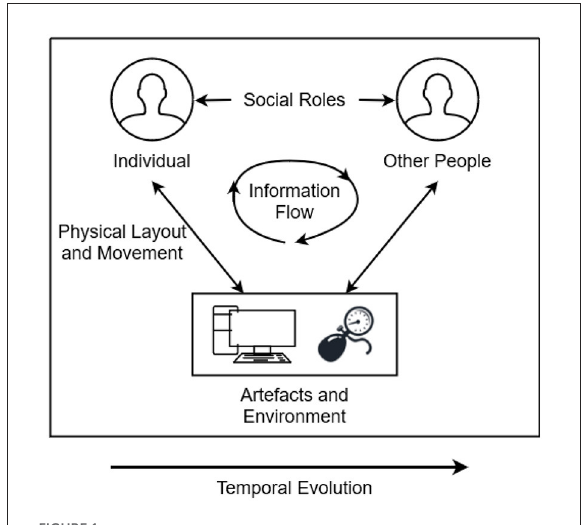
FIGURE1 Illustration of the interactions between each of the five DiCoT themes and how they work together to construct the entire cognitive